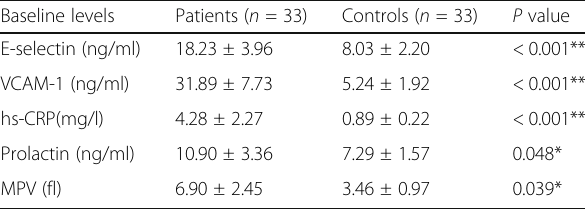
Table 4 Comparison between the patients on admission and the control individuals regarding laboratory data Baseline